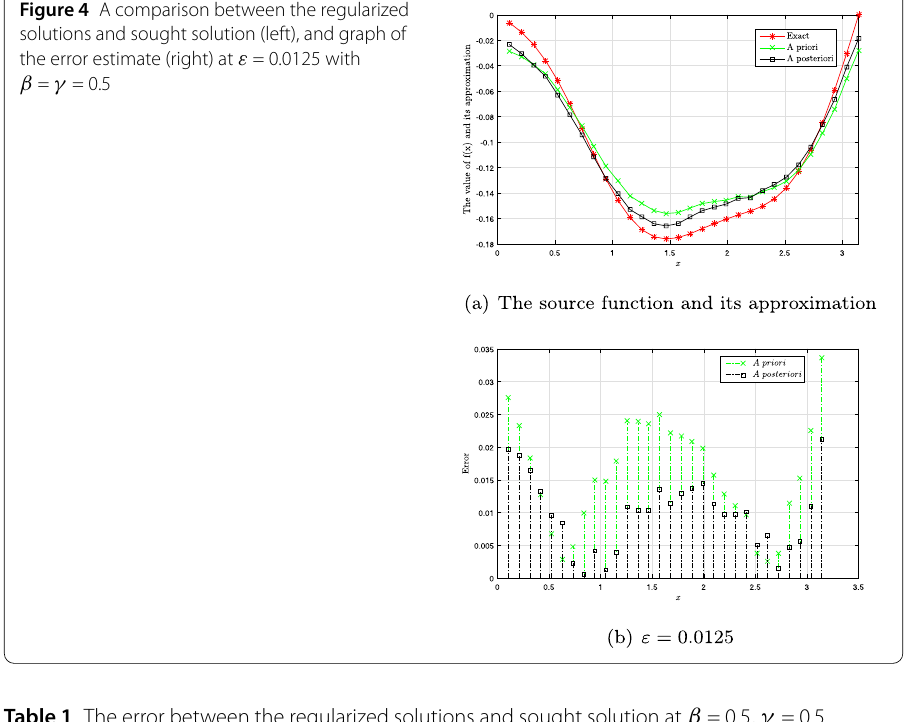
Figure 4 A comparison between the regularized solutions and sought solution (left), and graph of the error estimate (right) at ε = 0.0125 with β = γ = 0.5